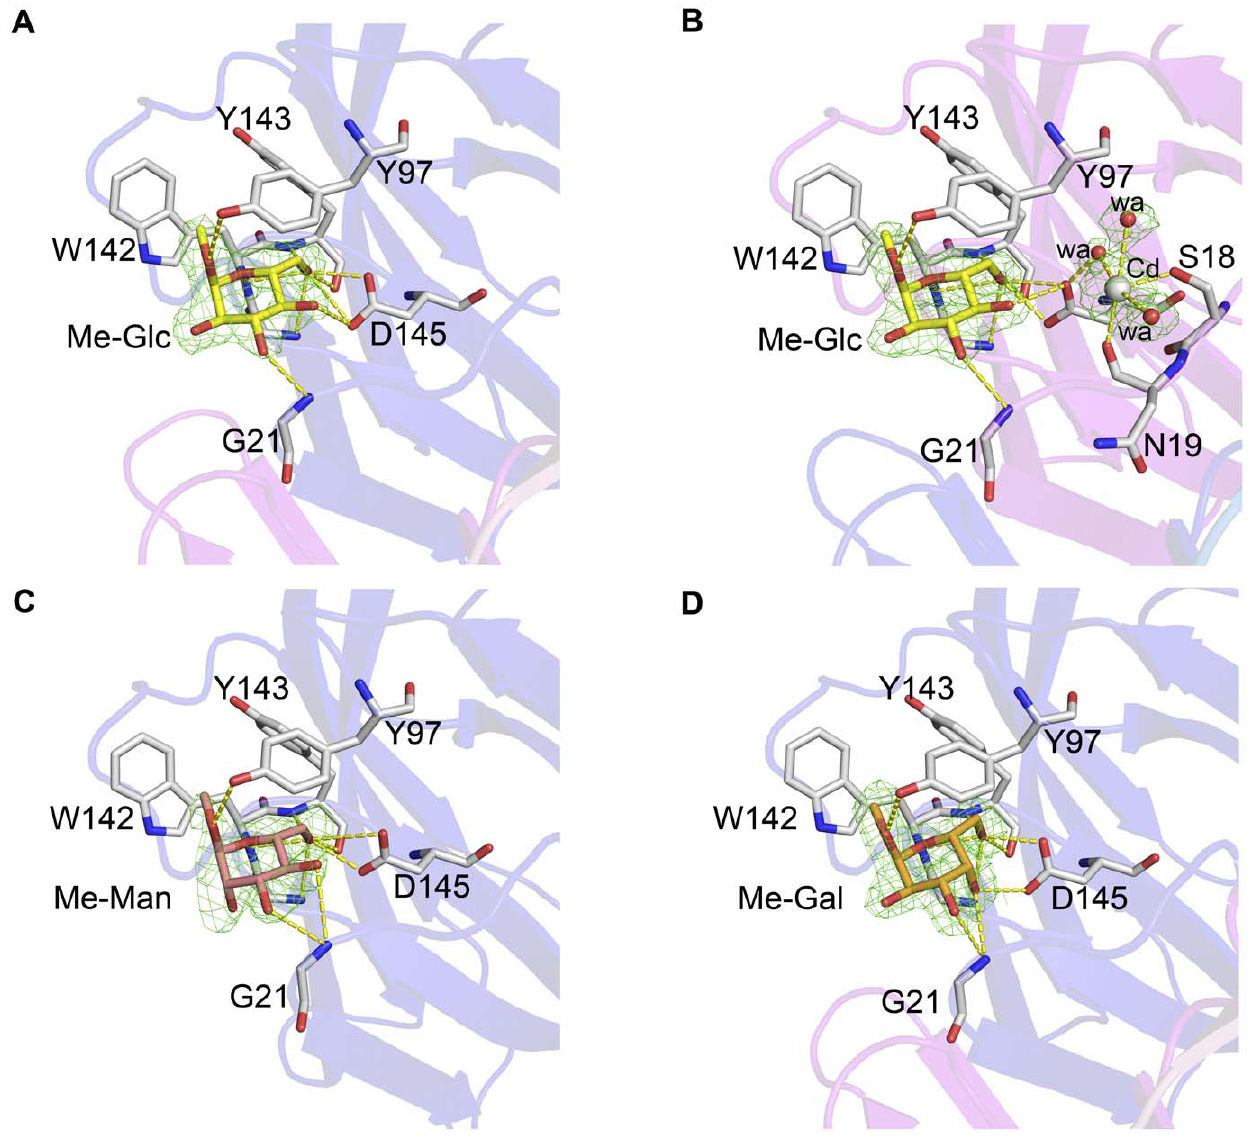
Figure 3. Electron density of carbohydrates from the structures of IPO–Me-Glc and IPO–Me-Man, IPO–Me-Gal. These maps are contoured at 1.0 s 2fofc electron density. The residues interacting with carbohydrates are highlighted. The carbohydrates Me-Glc only in chain A ( A ), Me-Glc with cadmium ion in chain B–D ( B ); Me-Man ( C ) and Me-Gal ( D ) form the hydrogen-bonding interactions (the yellow dashed lines) with the residues Gly21, Tyr97, Gly141, Trp142, Tyr143 and Asp145 of IPO.